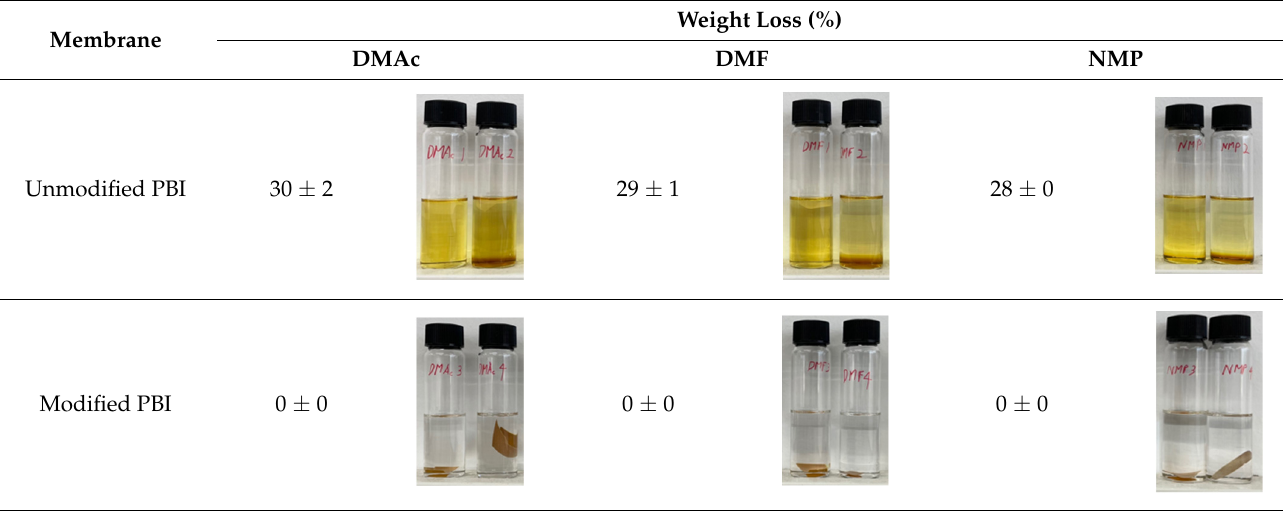
Table 2. Weight losses of PBI membrane samples after immersion in three organic solvents for five days. Photographic images of the membranes taken during the immersion test are also provided.